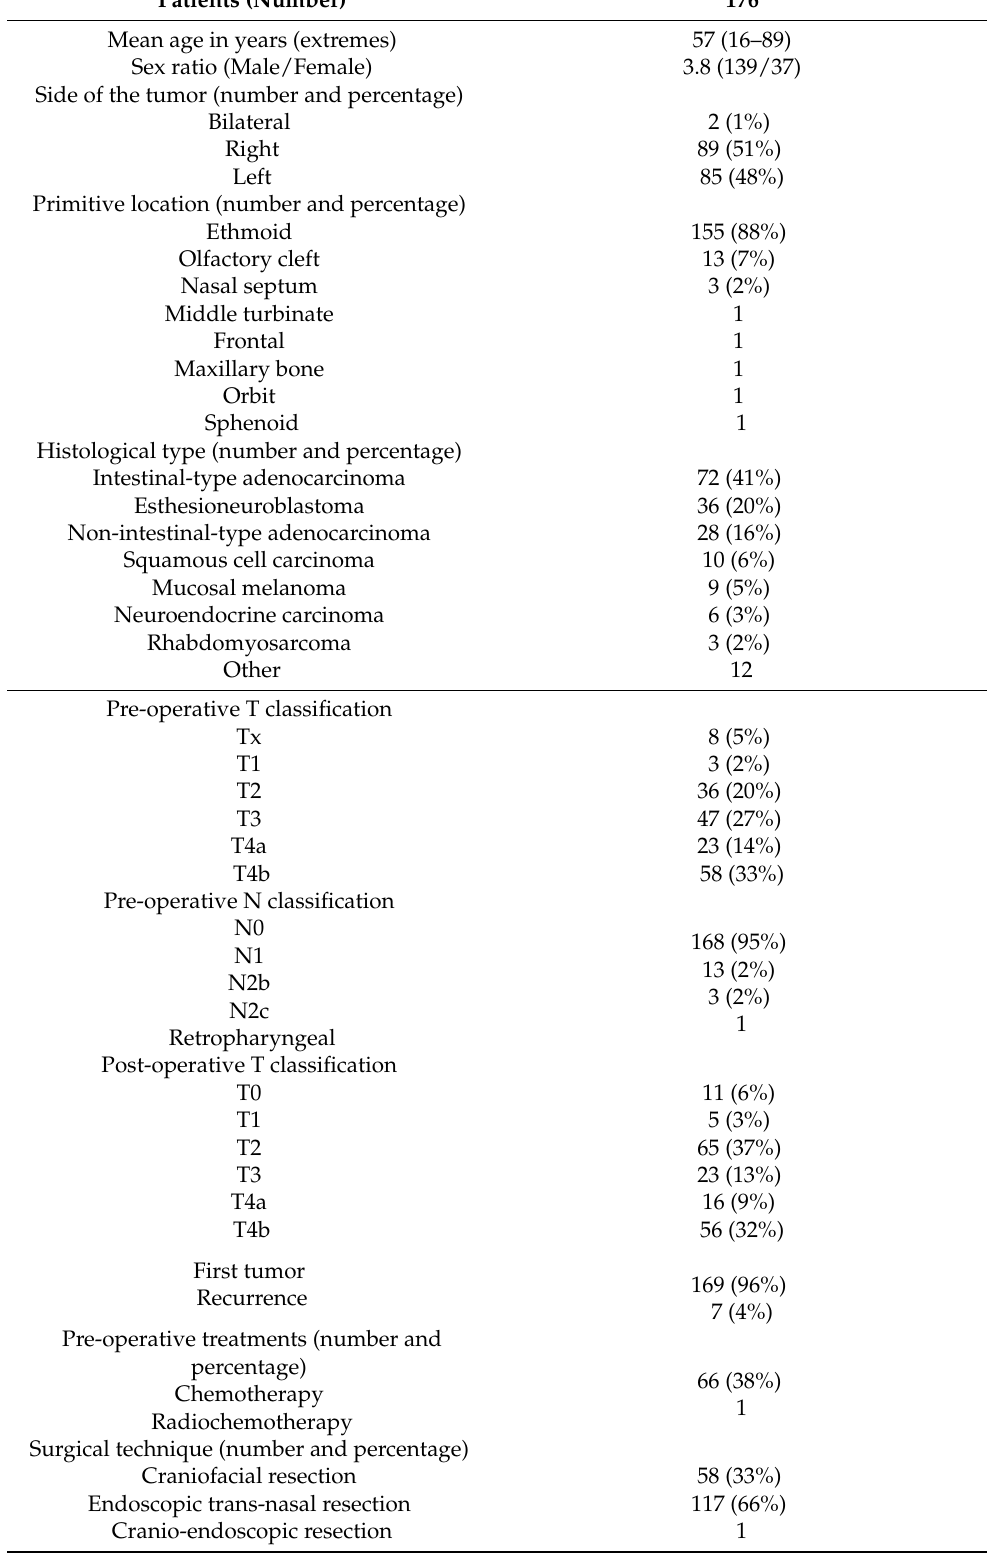
Table 2. Patient and tumor